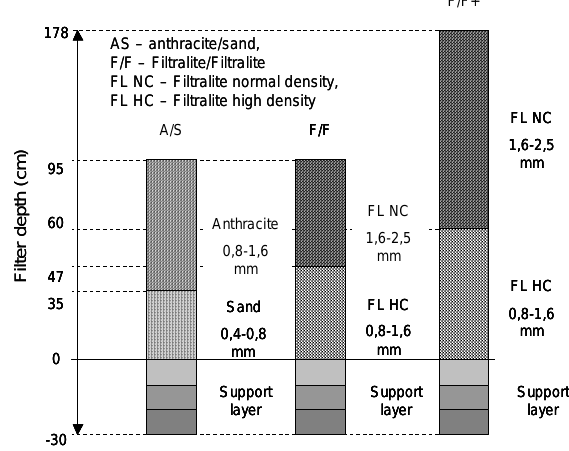
Figure 6. The continuous, uplow (Dynasand)